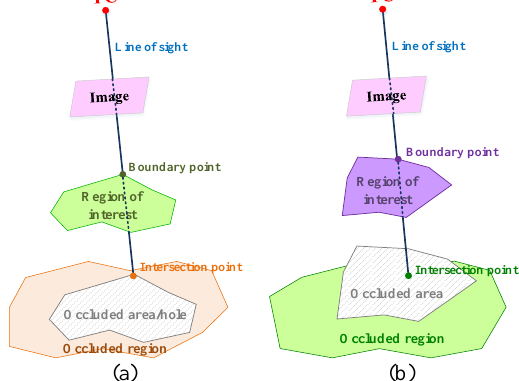
Figure 6. The occlusion of other regions by the region of interest (a) all the boundary points of the region of interest are projected inside the occluded region and (b) a section of the boundary points are projected inside the occluded region For each of the visible regions in an image, one can sequentially trace the visible boundary points, the points along the image footprint intersection with the region, if they happen to be inside the region, and the internal points that are occluded by the boundary points of the other regions. The outcome of this